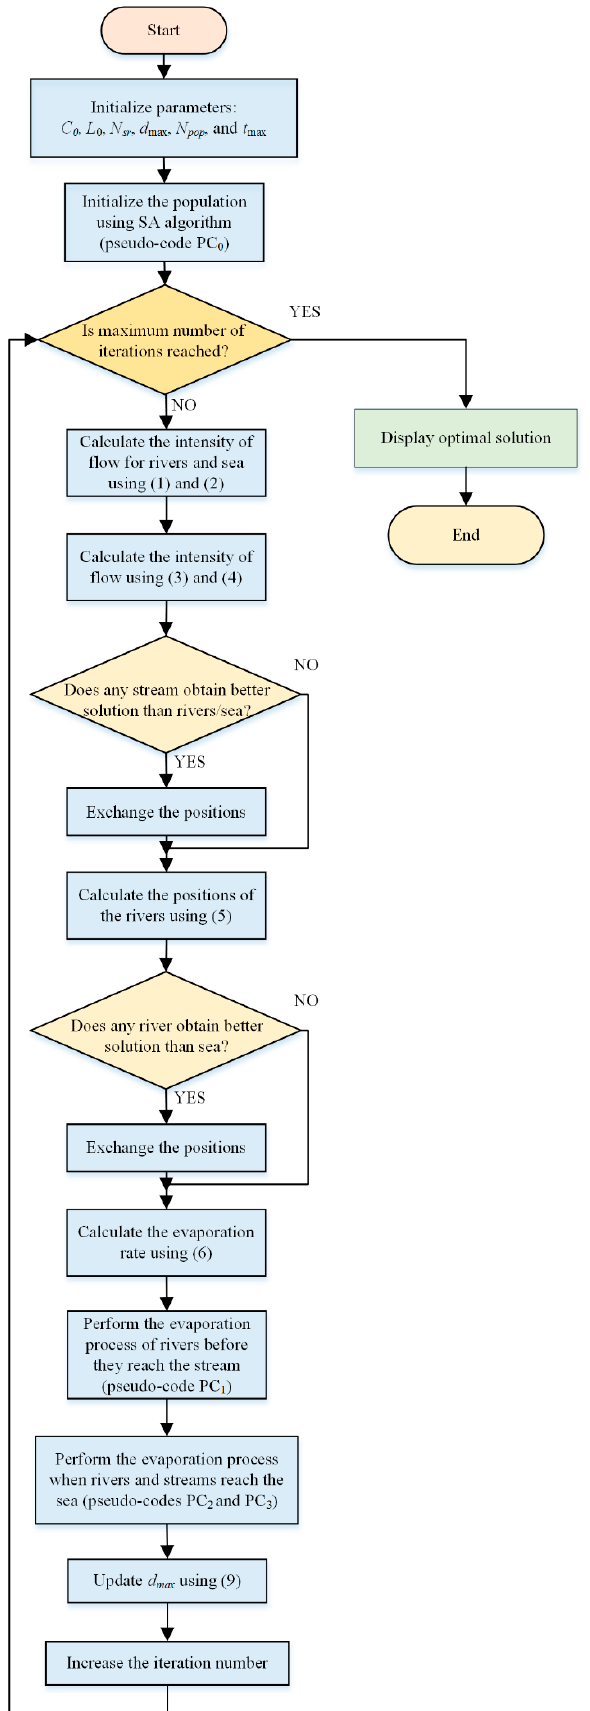
Figure 2. Flow chart of the SA-ERWCA.